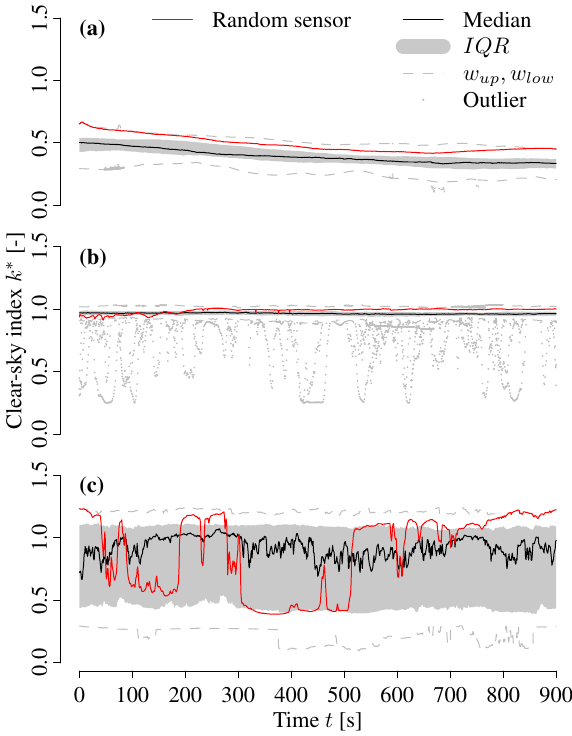
Figure 2. Examples of different spatiotemporal variability in clear- sky index k ∗ for three distinct cases of sky types: (a) mostly over- cast, (b) mostly clear, and (c) mixed. These representative subsets have been manually selected from the Jülich campaign and span 15min each. The time series of randomly selected sensors (red curves) are contrasted with summary statistics of field variability, represented as box plots (Table